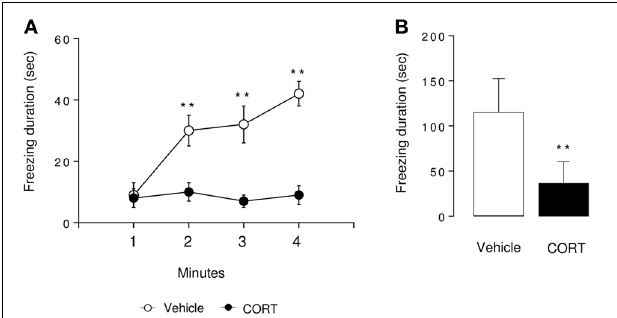
FIGURE 3 | Associative memory is impaired in CORT-treated mice in one-trial contextual fear conditioning. Contextual fear conditioning was produced by placing a mouse in the conditioning chamber and delivering one footshock 180s later. Mice were returned to the conditioning chamber 24h later to assess for context-elicited freezing. During Day 2, context-elicited freezing was analyzed for each minute of the test (ANOVA with repeated measures) (A) and during the whole session (B) . Values are mean ± s.e.m., n = 5–7 animals per group ∗∗ p < 0 . 01 vs. vehicle